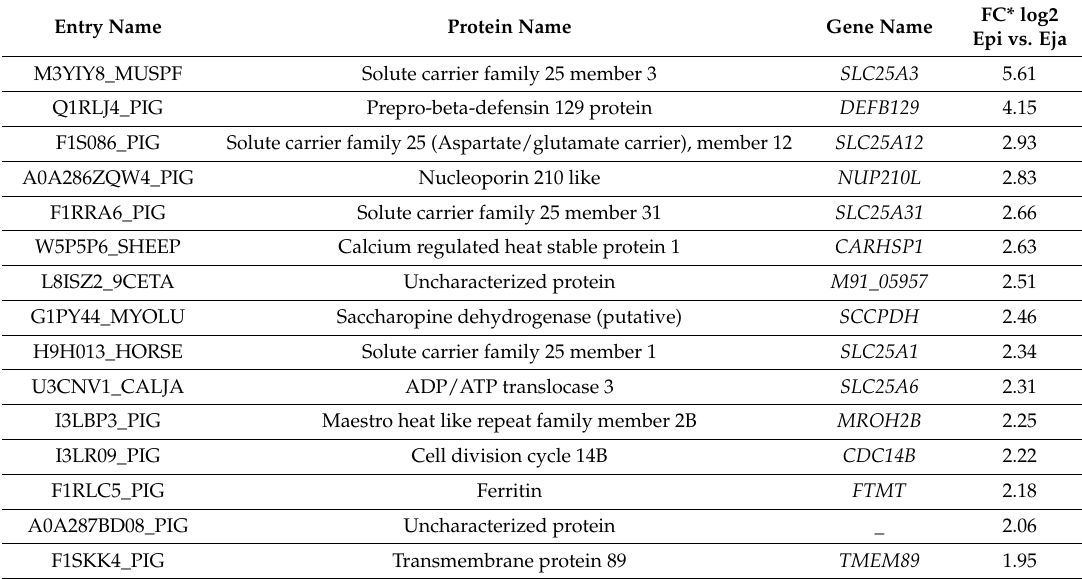
Figure 2. Venn diagram depicting the distribution of differentially abundant proteins among fresh (F) and frozen-thawed (FT) spermatozoa collected from cauda epididymis (Epi) and the ejaculate (Eja). Table 2. Proteins differentially abundant between fresh pig spermatozoa collected from cauda epididymis (Epi) and ejaculate